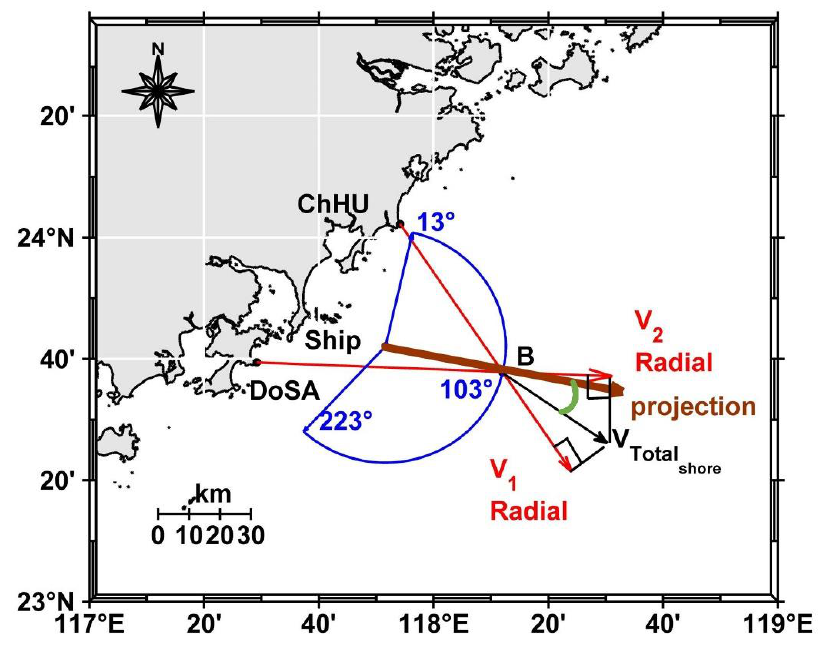
Figure 13. Total vector currents: V Total (black line) calculated from two radial currents V 1 (red line) shore and V 2 (red line) by the two shore radar sites; the carmine line (from the ship site to ‘B’) denotes the radial projection of V Total ; the green angle denotes the projection shore